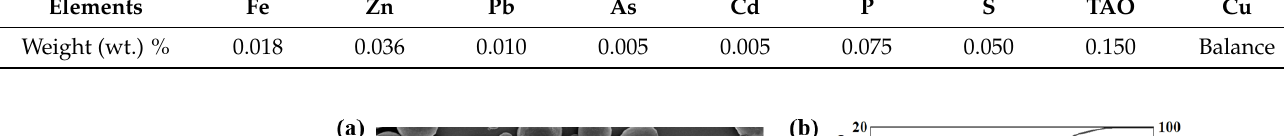
Table 1. Chemical composition of pure Cu powder employed in this research.